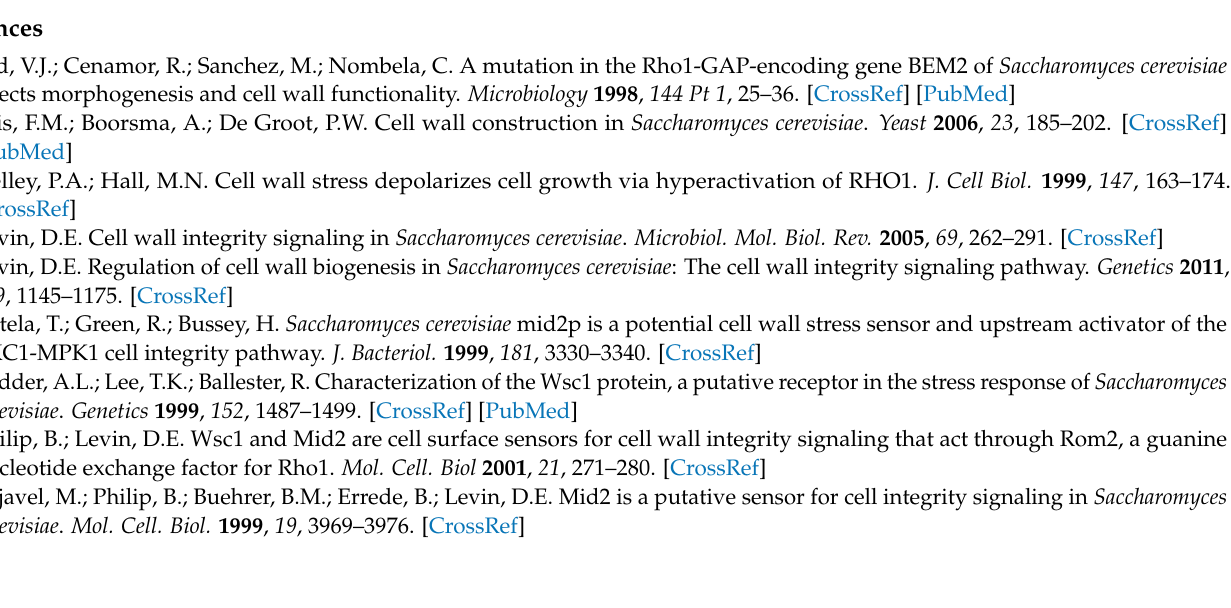
Figure S4—Induction of PZ3EV-Pkc1pR398P causes zygote formation and fusion defects. Figure S5— Hyperactivation of PKC1-R398P inhibits the pheromone response. Table S1—Yeast Strains. Table S2—